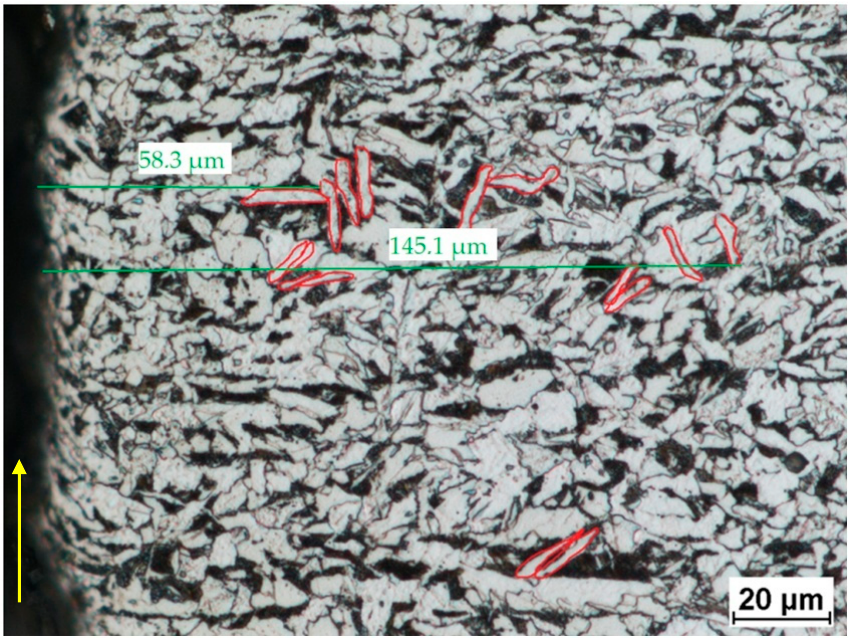
Figure 9. Widmanstätten patterns—elongated ferrite grains (a pressure of 380 MPa and a cutting speed of 250 mm/min).